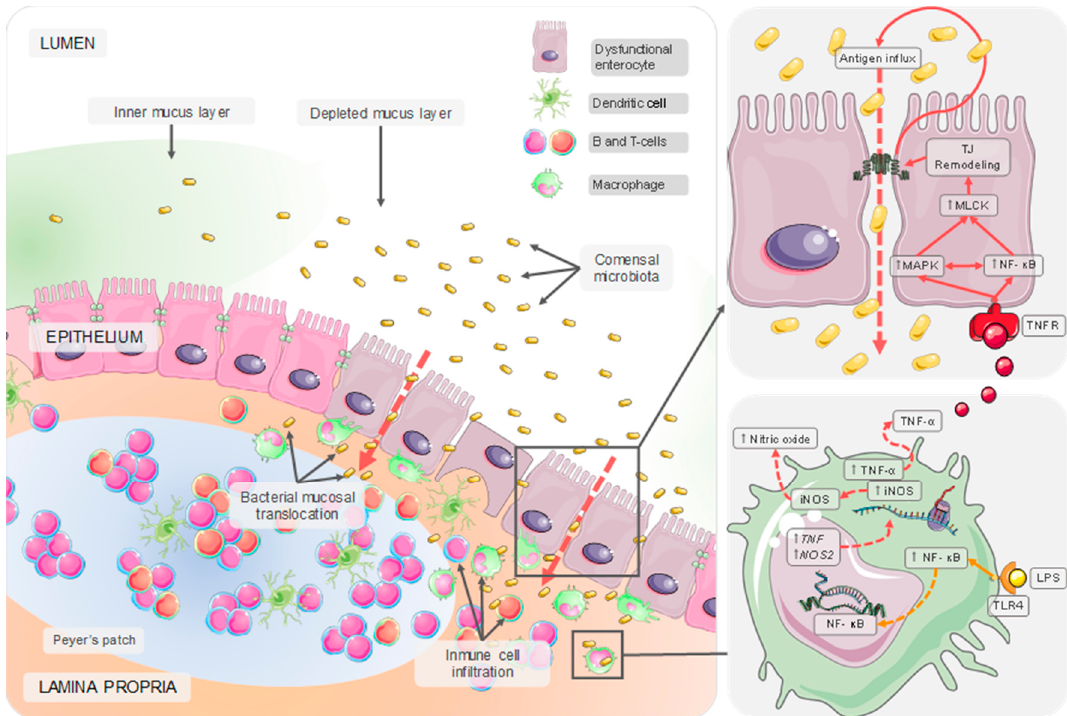
Figure 1. Dysfunctional intestinal mucosal. Chronic exposition to detrimental environmental stimuli, including several food components, may lead to dysbiosis, mucus layer depletion, and breakdown of the epithelial barrier. Constitutive stimulation of NF- κ B signaling by bacterial endotoxins induce overproduction of pro-inflammatory cytokines and reactive species of oxygen and nitrogen, feeding back the epithelial barrier disruption and immune cell infiltration.